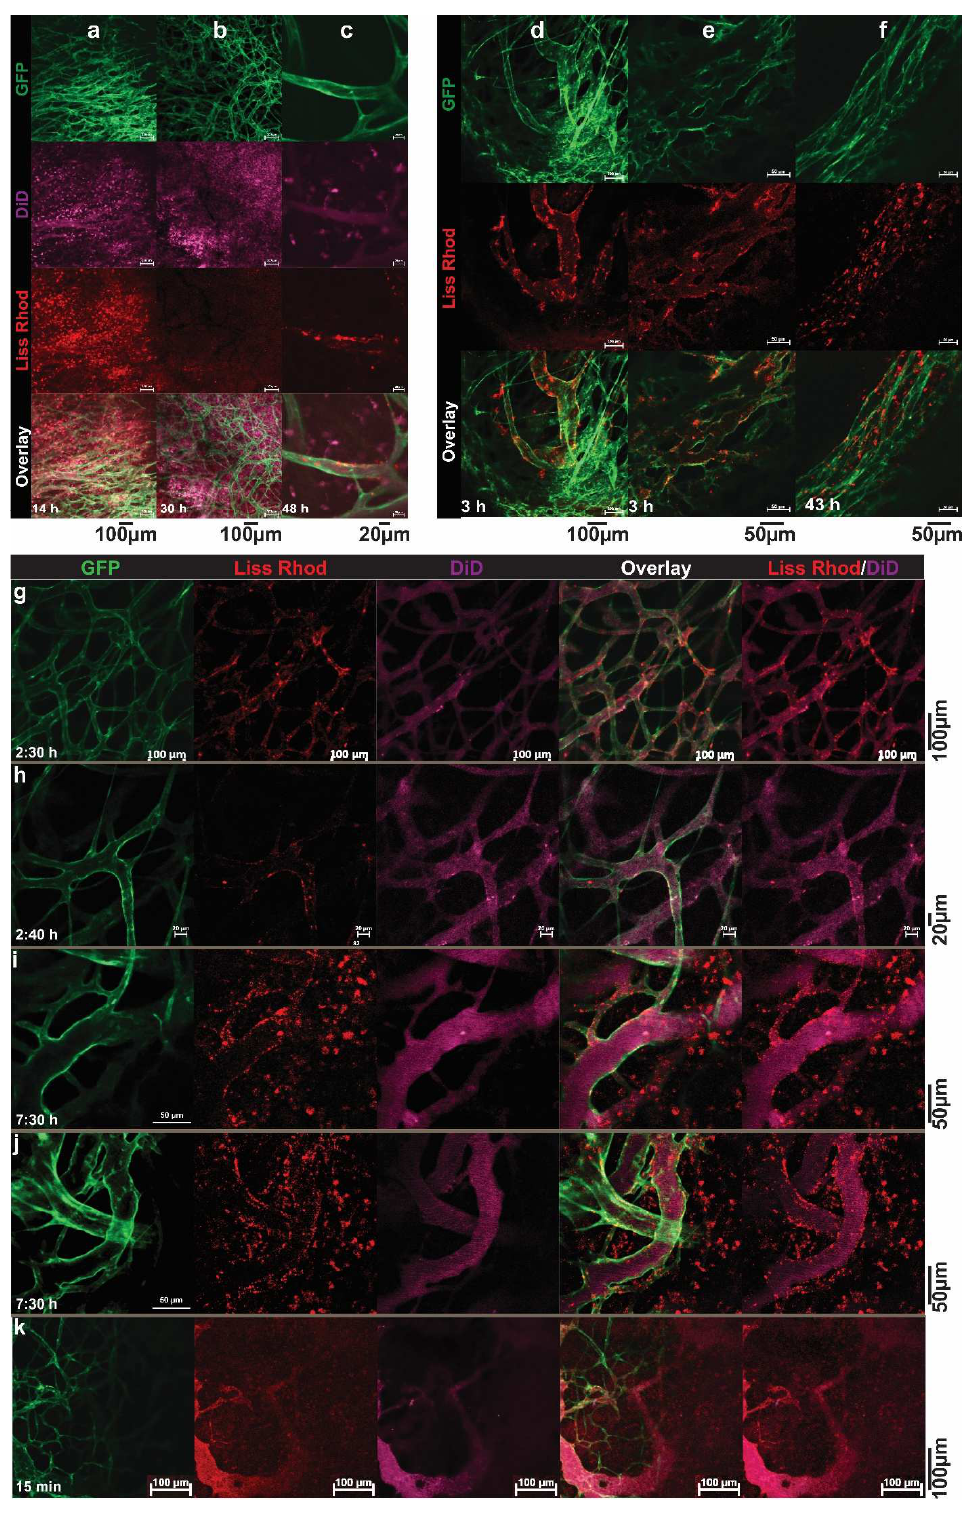
Figure 11. Intravitalmicroscopyimagingoftheintratumoralbehaviorofdifferentligandmodifiedliposomes inside B16F0 tumors, using a dorsal skin-fold chamber. While in some regions both Rho-PE-labeled